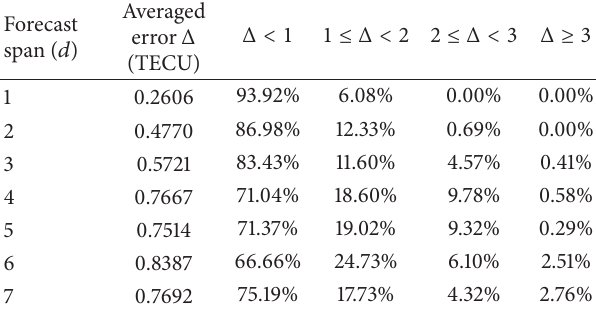
Table 4: Statistics of forecasting precisions of different time scales by linear